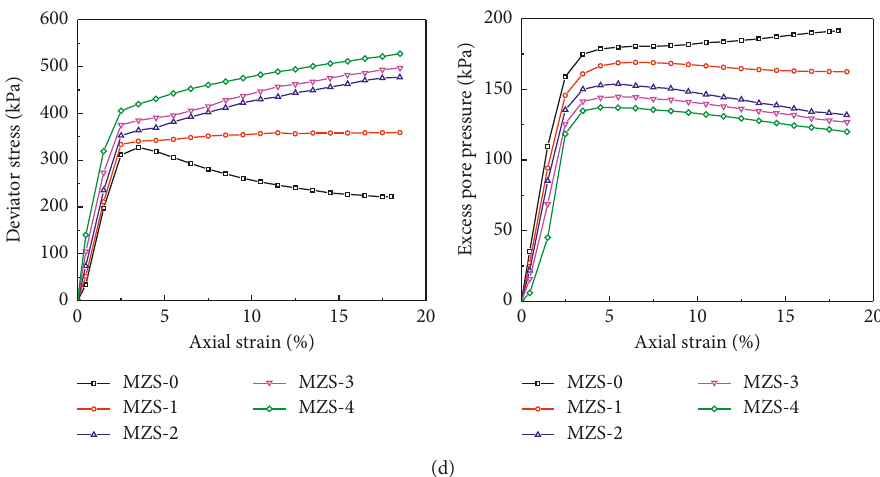
Figure 7: Undrained shear (ICUC) behavior of treated loess with different contents of lignin at different effective confining pressures. (a) 80kPa. (b) 140kPa. (c) 200kPa. (d) 300kPa.